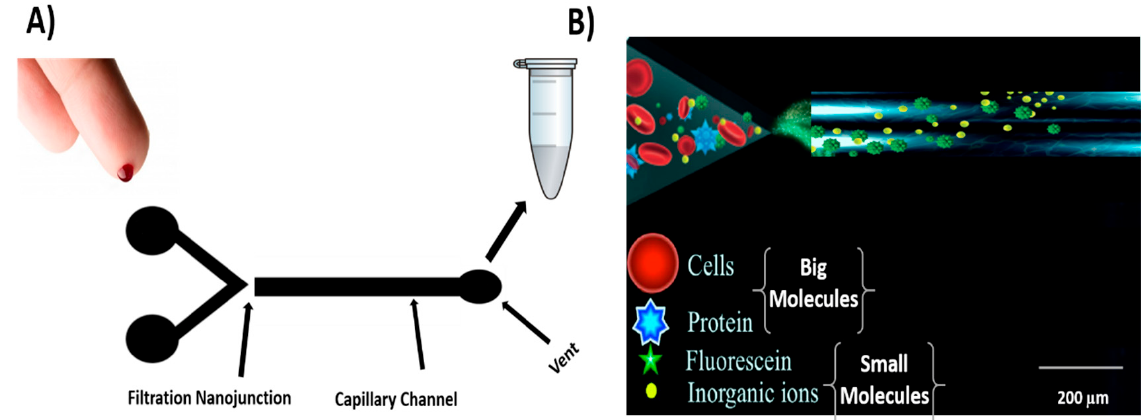
Figure 2. ( A ) Schematic of the operation of the microfluidic device (dimension not to scale) indicating the filtration process and ( B ) illustration of the filtration device concept. Nanochannel was formed by controlled dielectric breakdown of the tip of the V-channel and the filtration channel. Large molecules are blocked (Cells and Proteins) while small molecules pass the filtration channel.